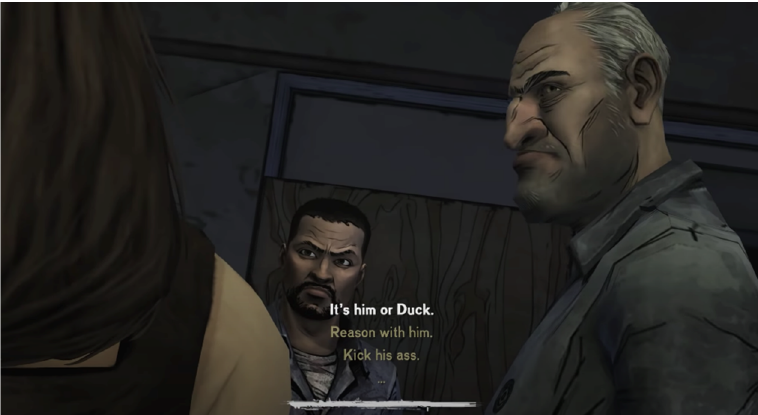
Figure 3. Options for the player-character, Lee (center) for dealing with an aggressive man (right) who is threatening Kenny’s son, Duck.